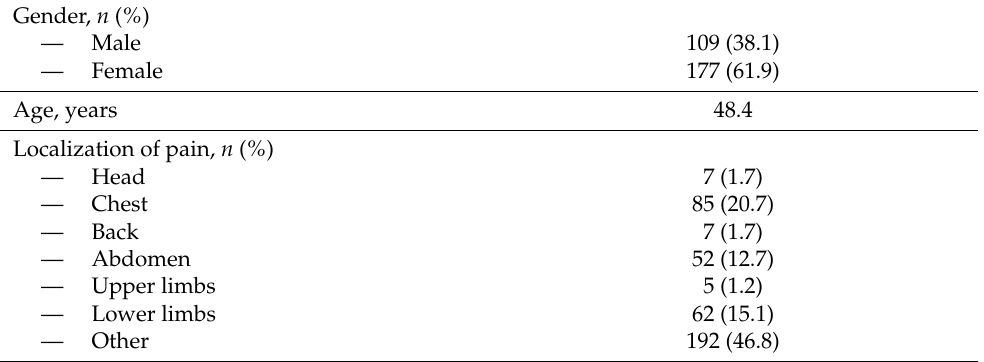
Table 2. Baseline characteristics of patients and